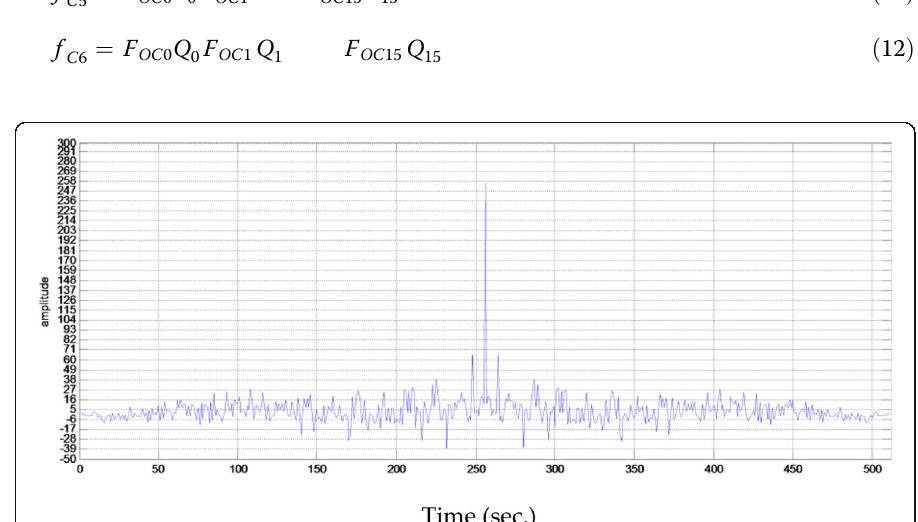
Fig. 9 Autocorrelation function of f C